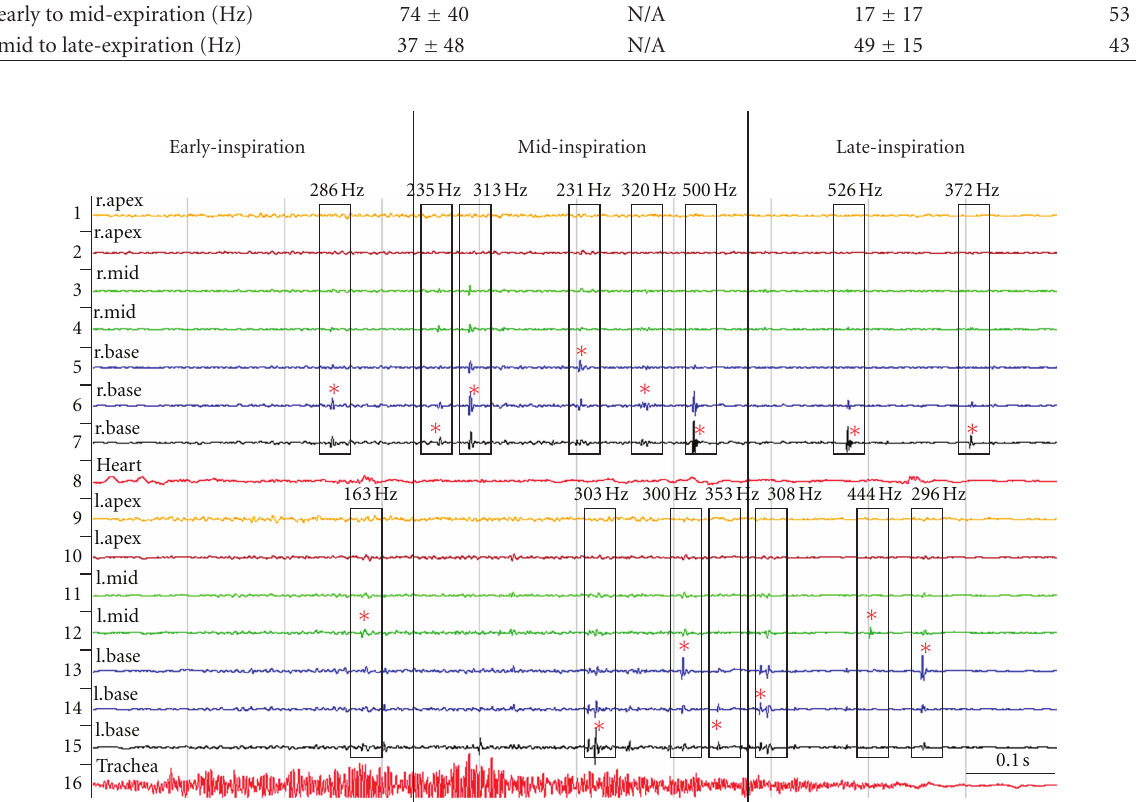
Figure 1: A time amplitude plot of inspiratory lung sounds recorded from a patient with pneumonia. Channels 1 to 7 were recorded from the right lung, channels 9 to 15 were recorded from the left lung, channel 8 was recorded from the heart (not used for crackle analysis), and channel 16 was recorded from the trachea (not used for crackle analysis). A black border indicates crackle families, mother crackles are marked by a star “ ∗ ”, crackle pitch is shown on top of each border. Thick vertical lines indicate the boundaries between early, mid-, and